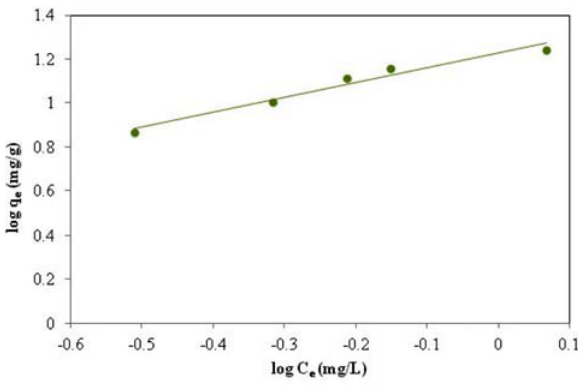
Table 2. Langmuir and Freundlich isotherm parameters